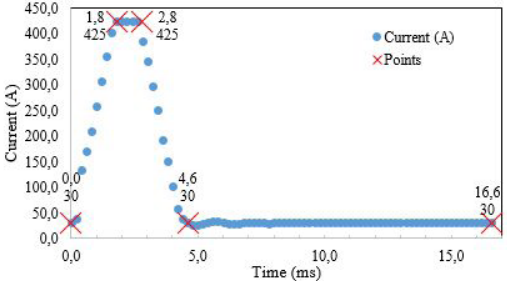
Figure 2. OTC GMAW DC pulsed waveform.